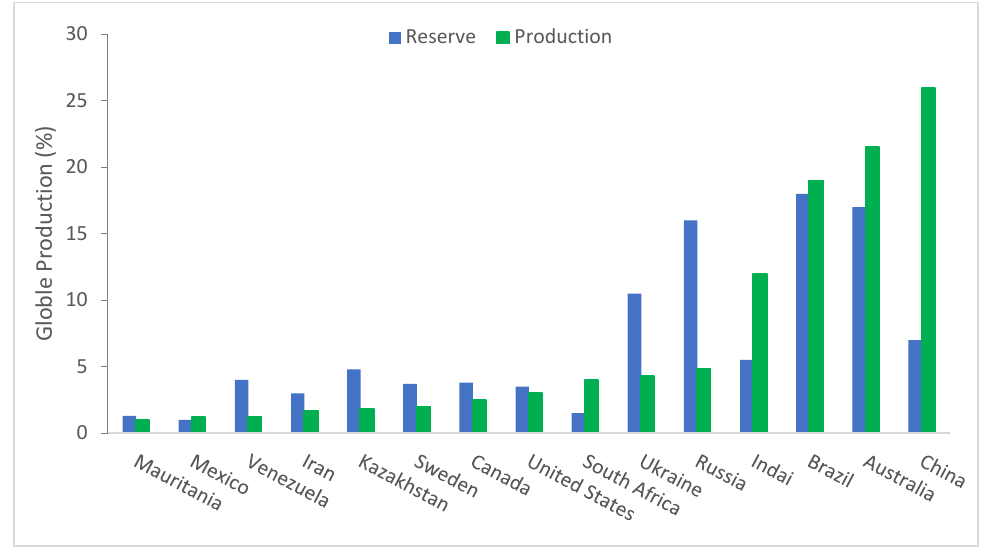
Figure 1. Worldwide production of iron ore (data source [44]).